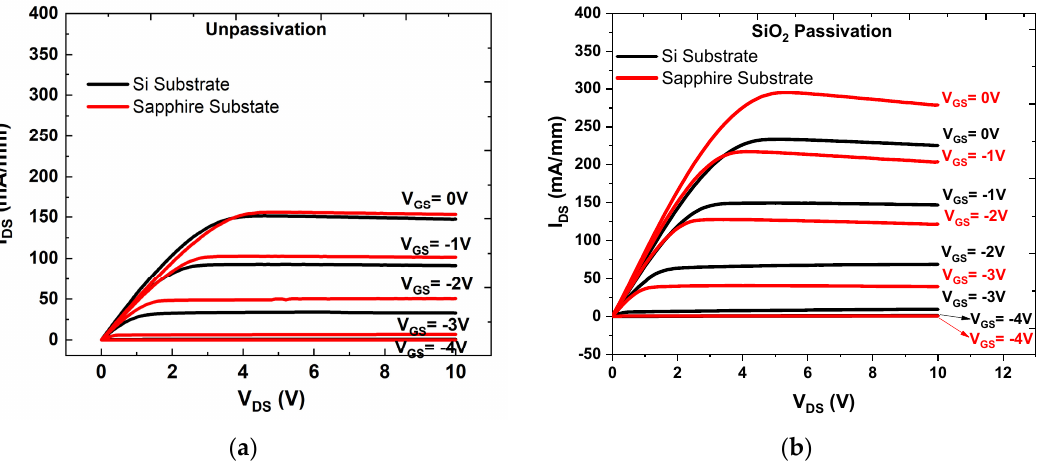
Figure 2. On ‐ state I DS –V DS curves of AlGaN/GaN HEMTS on Si and sapphire substrates ( a ) without and ( b ) with SiO 2 passivation.